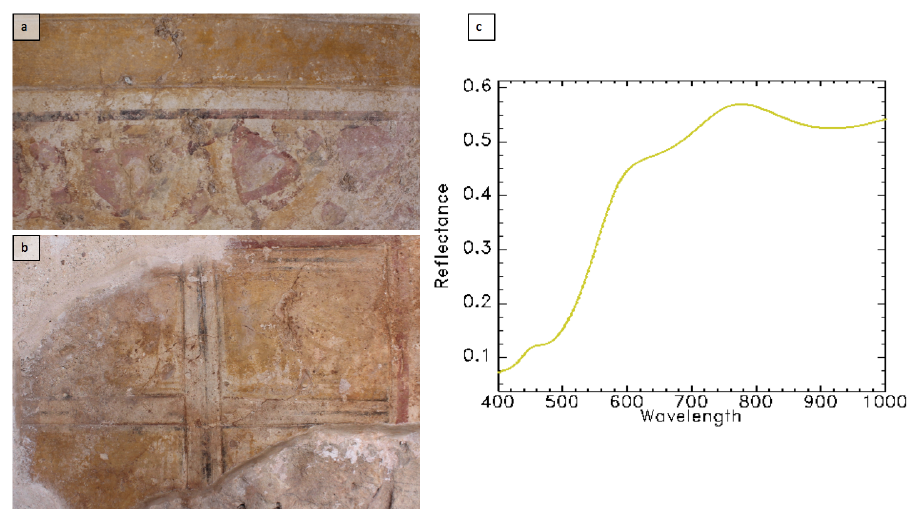
Figure 16. ( a ) A yellow band in the thalamos chamber of Tomb 3882 (N3); ( b ) A false door in Tomb 6, painted with yellow ochre (O); ( c ) The reflectance spectrum of